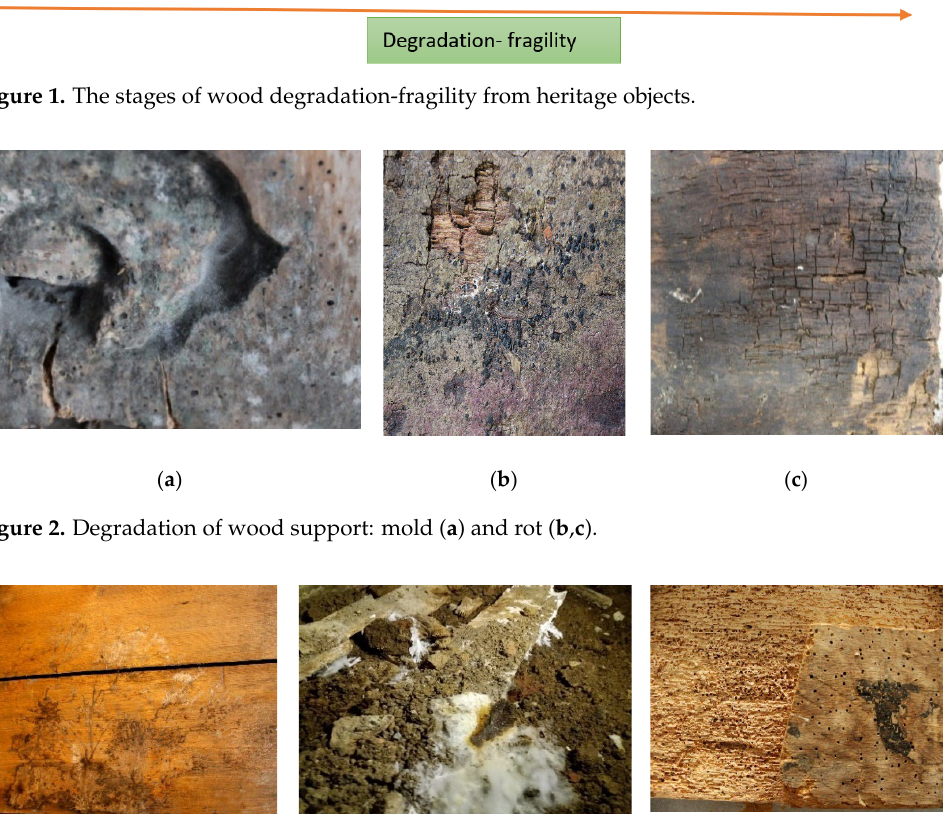
Figure 2. Degradation of wood support: mold ( a ) and rot ( b , c ).